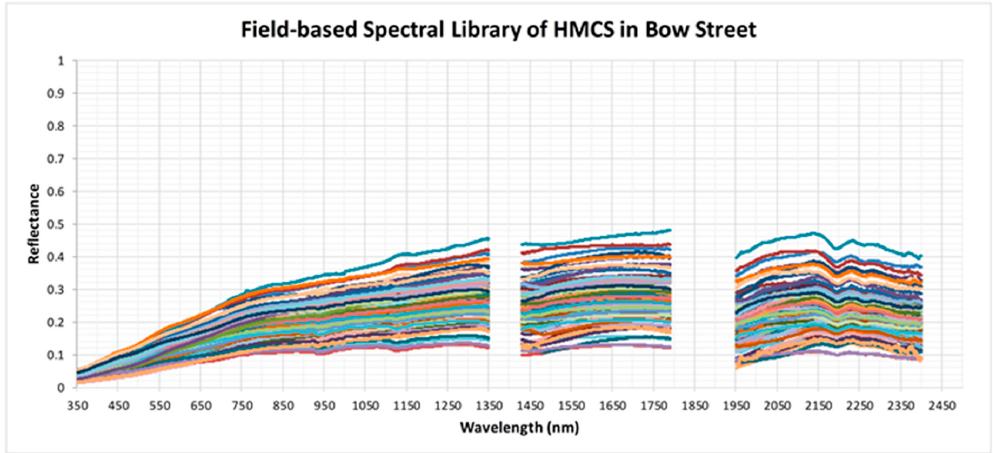
Figure 6. Field-based spectral library of heavy metal soil contamination (HMSC) at the Bow Street site. Spectral regions related to water vapor absorption (1350–1430, 1790–1950 and 2400–2500 nm) have been removed.